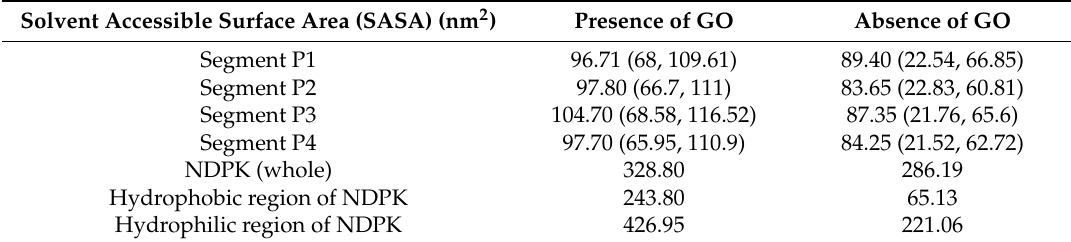
Table 2. Solvent Accessible Surface Area (SASA).